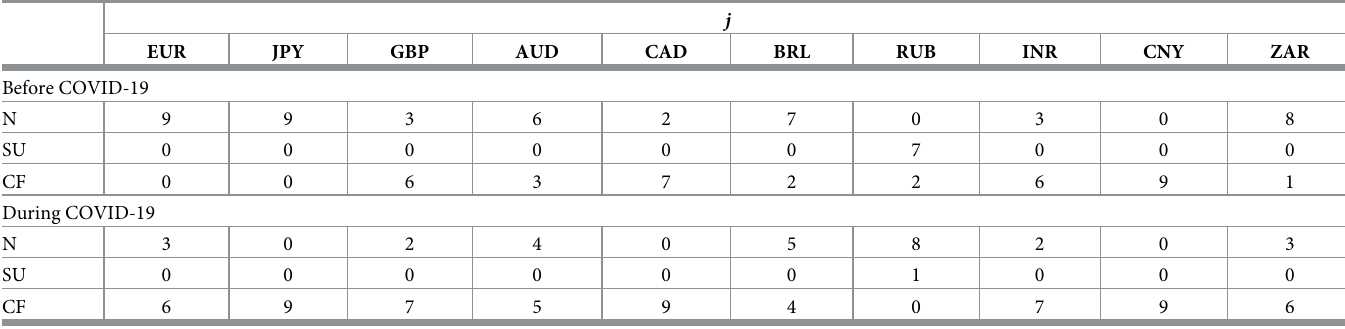
Table 6. Number of CoVaR 5 % models with the best conditional coverage property. j j�